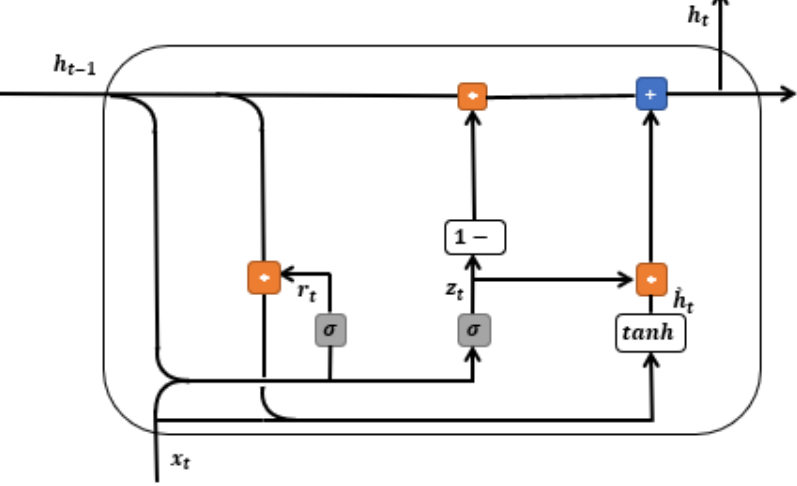
Figure 1. Cell structure of the Gated Recurrent Unit (GRU).